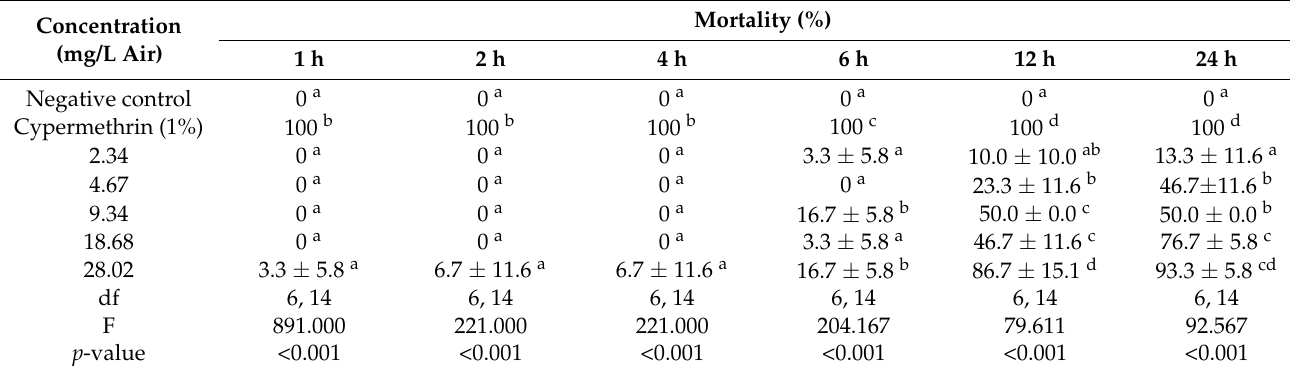
Table 5. Percent mortality (mean ± SD) of insecticidal activity of Plectranthus amboinicus essential oil against Tabanus megalops by fumigant toxicity test at different concentrations.